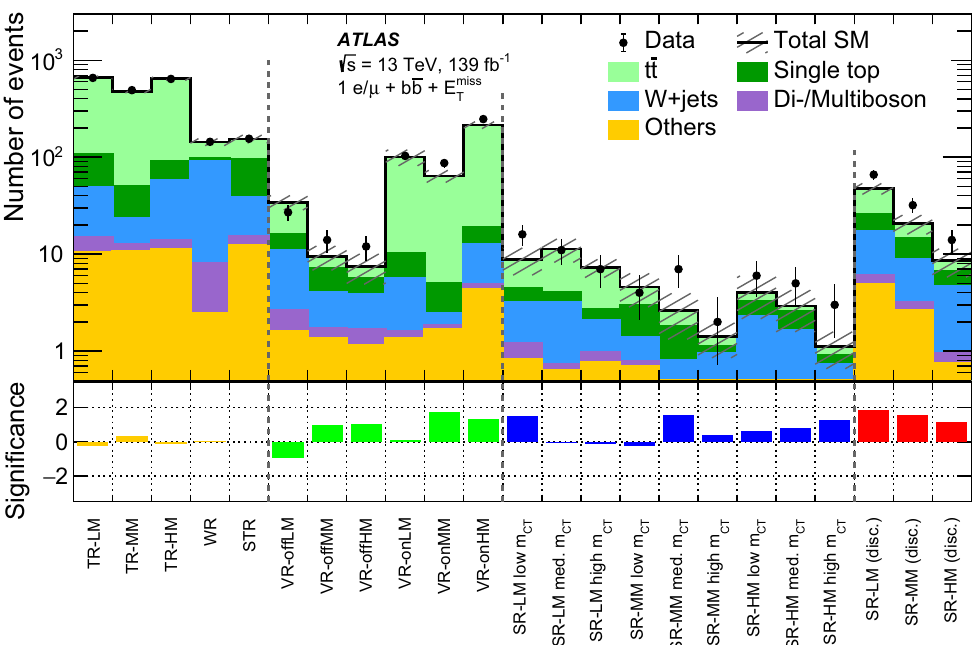
Fig. 4 Comparison of the observed and expected event yields in con- trol, validation, exclusion, and discovery signal regions. Uncertainties inthebackgroundestimatesincludeboththestatistical(inthesimulated